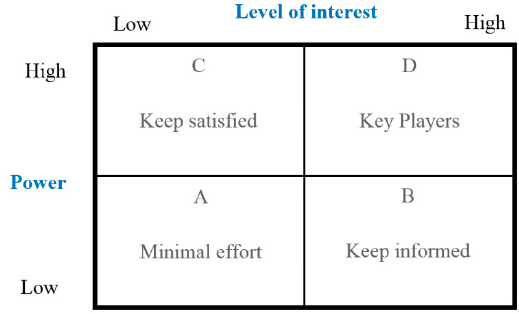
Figure 3. Power–interest matrix (adapted from Mendelow